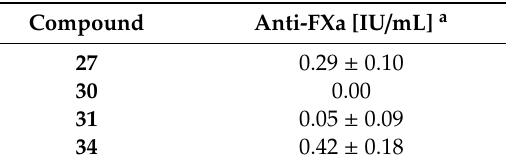
Table 10. Anti FXa assay values of selected